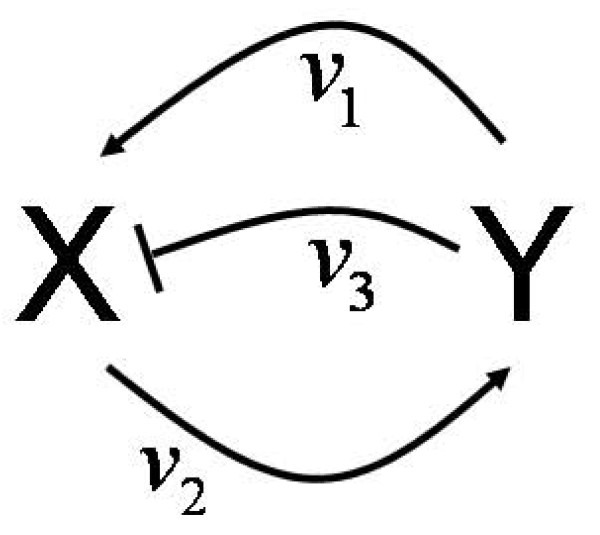
Interaction graph of system (2). It follows directly from the off-diagonal elements of the general Jacobian (3). The positive feedback loop is the only instability causing structure (ICS) in the system, allowing for a locally unstable steady state (presupposition for bistability).